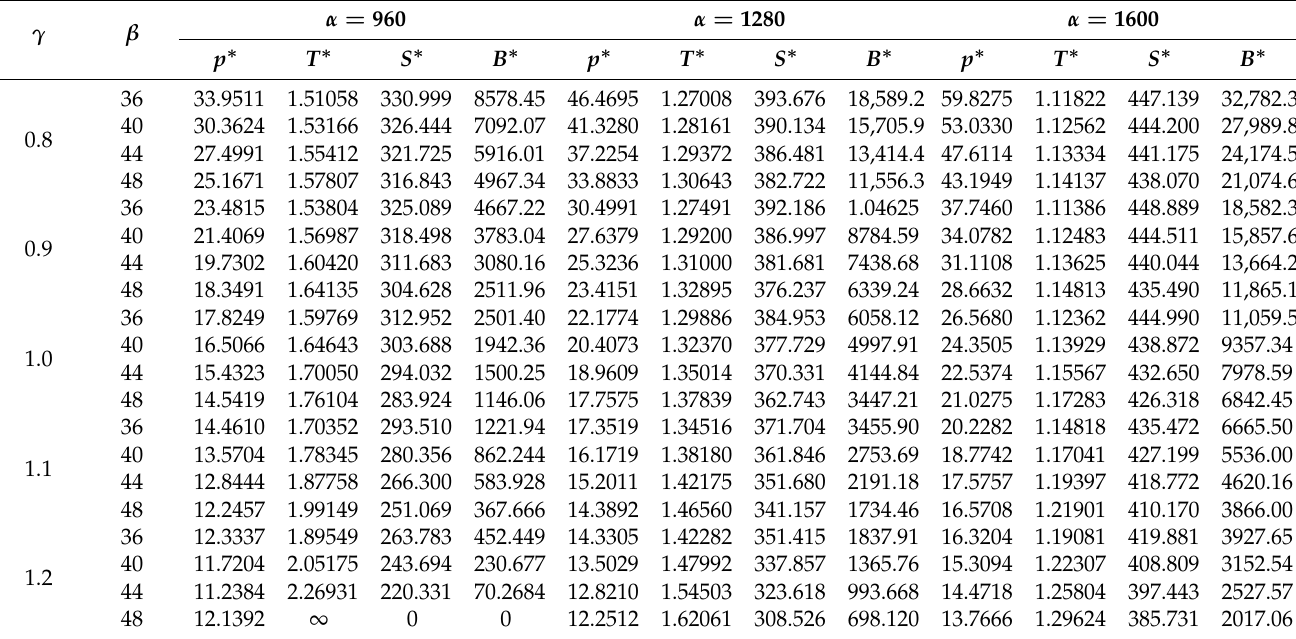
Table 3. Sensitivity of the optimal policy ( p ∗ , T ∗ , S ∗ ) and the maximum profit B ∗ to variations of the parameters α , β and γ when n = 1.